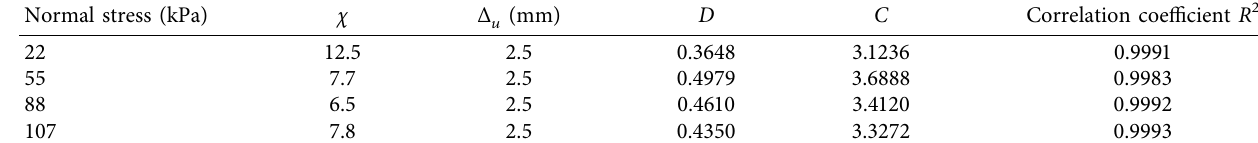
Table 2: Model parameter values under different normal stresses obtained by fitting. Normal stress (kPa)